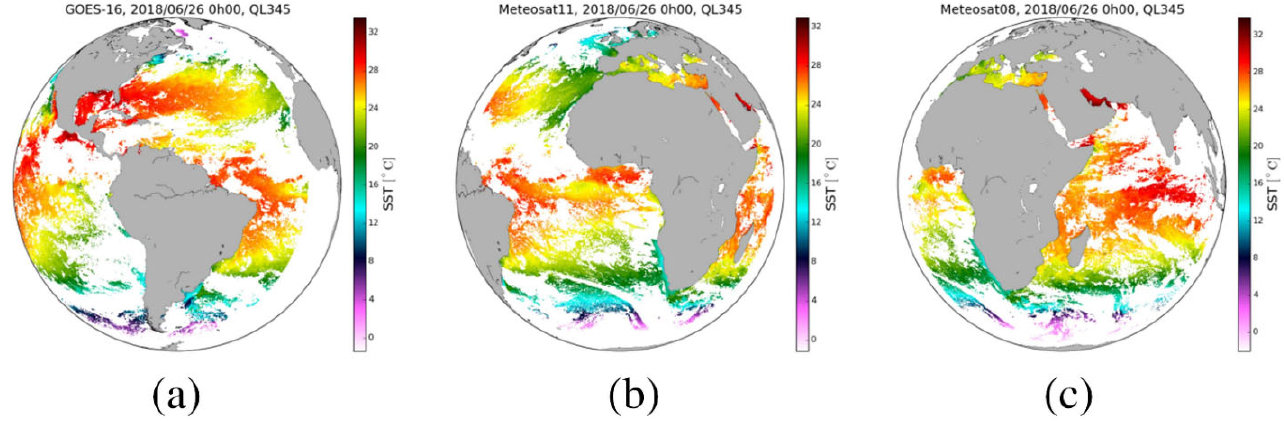
Figure 7. SST maps from ( a ) GEOS ‐ 16, ( b ) Meteosat ‐ 11, and ( c ) Meteosat ‐ 18 [151].